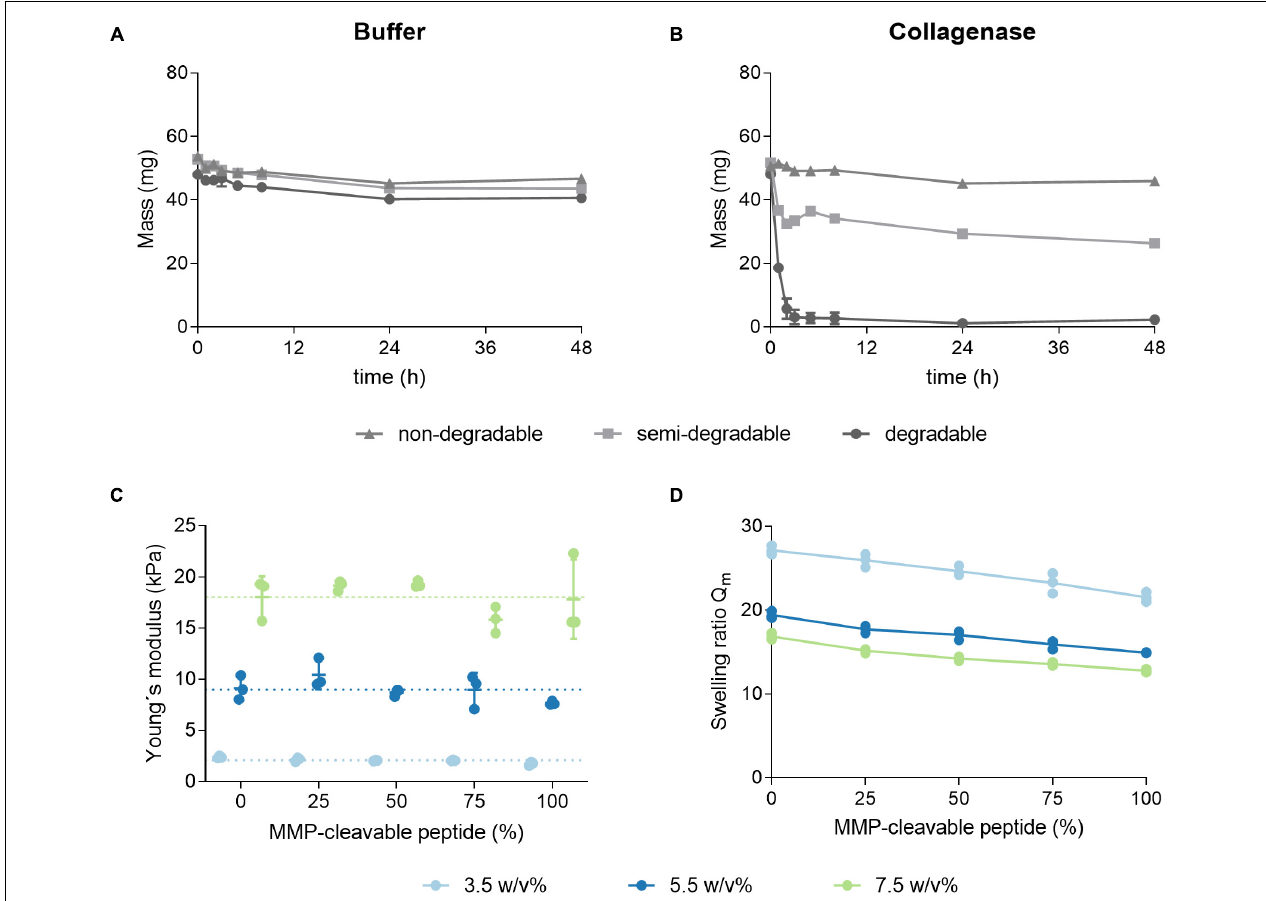
Figure 5 | Effect of a stepwise replacement of the PEG-dithiol linker with the MMP-cleavable peptide on degradation, elasticity and swelling ratio. (A,B) Enzymatic and hydrolytic degradation of non-degradable, semi-degradable and degradable hydrogels. 3.5 w/v% hydrogels were prepared by thiol-Michael addition reaction using either the PEG-dithiol (non-degradable), a mixture of PEG-dithiol and the MMP-cleavable di-cysteine peptide (semi-degradable, molar ratio 1:1) or the peptide alone (degradable). Hydrogels were swollen overnight in buffer and mass changes due to enzymatic degradation were monitored over 48 h when incubated in buffer (A) or with collagenase (B) . (C,D) Hydrogels were formed with three different PEG polymer concentrations by thiol-Michael addition reaction with a stepwise replacement of the PEG-dithiol crosslinker by the MMP-cleavable di-cysteine peptide. (C) The Young’s moduli of hydrogels were determined by shear rheological measurements. (D) Swelling ratios of hydrogels with increasing degradability. Swelling ratios were calculated by dividing the mass of the equilibrium-swollen hydrogel by the dry mass; mean and standard deviation of triplicates are